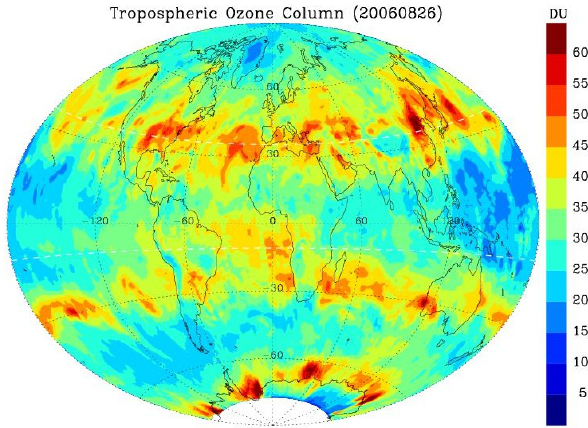
Fig. 11. Global tropospheric ozone field on 26 August 2006 as shown in Liu et al. (2010). From http://www.cfa.harvard.edu/ atmosphere/ozone_tropo.html.